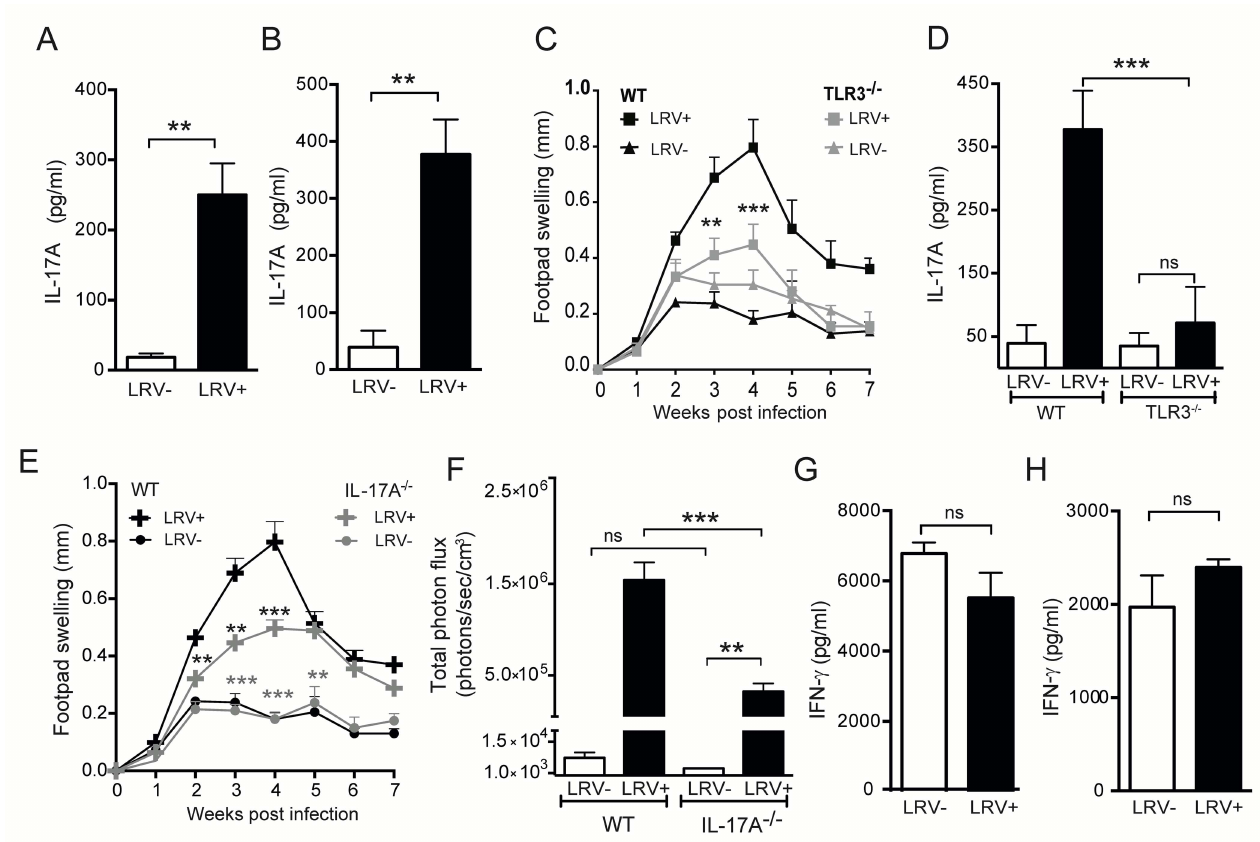
Fig 2. LRV1 inducesIL-17Asecretionin murine leishmaniasis and contributes to LRV1-mediateddisease severity. Mice deficient in IL-17A or TLR3 and theirWT controls(C57BL/6)were infected in the hind footpads with 3x10 6 of eitherLRV1+ or LRV1- L . g stationary-phase promastigotes. At the peak of infection (4 weeks post-inoculation),cells fromthe footpad lesions and poplitealLNs were re-stimulated ex vivo . IL- 17A secretionin WT mice was quantifiedin the supernatant by ELISA in (A) intra-lesional biopsiesand (B) poplitealLNs. (C) Changein footpad swelling in TLR3 -/- and WT mice was measuredweekly as a proxy for disease score. (D) IL-17AsecretionfrompoplitealLN cells was also comparedbetweenWT and TLR3 -/- mice. (E) Changein footpad swelling in IL-17A -/- and WT mice was measuredweekly as a proxy for disease score. Statistical analysis is indicated in black for comparisonbetween WT and IL-17A -/- LRV1+ infected mice, and in grey for comparison between IL-17A -/- LRV+ and LRV- infected mice. (F) At the peak of infection (week 4), the parasiteburden of the mice depictedin (E) was quantifiedby in vivo parasite luminescence, afterinjectingmice intra-peritoneallywith luciferin.As previously for IL-17A,IFN- γ secretionin WT mice was quantified in the supernatant of restimulated cells by ELISA in (G) intra-lesional biopsiesand (H) poplitealLNs. Graphs are representative of a minimumof 3 independent experiments, using at least 5 mice per condition and presentedas mean ± SEM. Significance tested by an unpaired,parametric t -test (bargraphs) or one-way Anova (diseasescore),and indicatedas * : P < 0.05, ** P < 0.005, *** P < 0.0001.